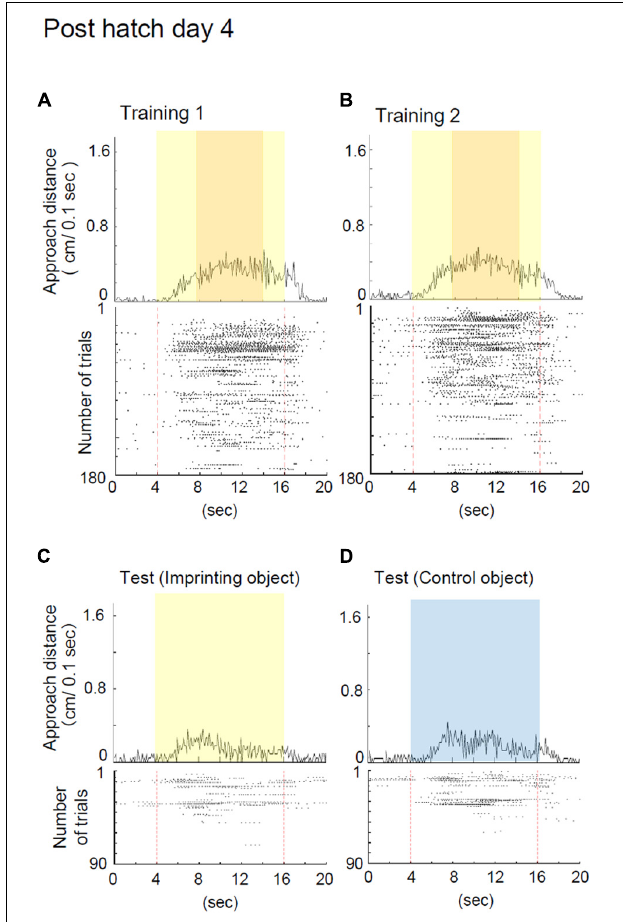
FIGURE 4 | Representative behavior of a chick at Phd 4 in the imprinting training and test. (A) Averaged approach distances and raster plots of each trial in training 1 are shown. In training 1, the chick responded to the moving object and, in some instances, responded to the object before it started moving. (B) Averaged approach distances and raster plots of each trial in training 2 are shown. In training 2, the chick responded to the object in a similar manner to training 1. (C) Averaged approach distances and raster plots in the imprinting object trials of the test are shown. Initially, the chicks responded to the static state of the yellow object, and gradually stopped responding. (D) Averaged approach distances and raster plots in the control object trials of the test are shown. Initially, the chicks responded to the blue object, and gradually stopped responding.